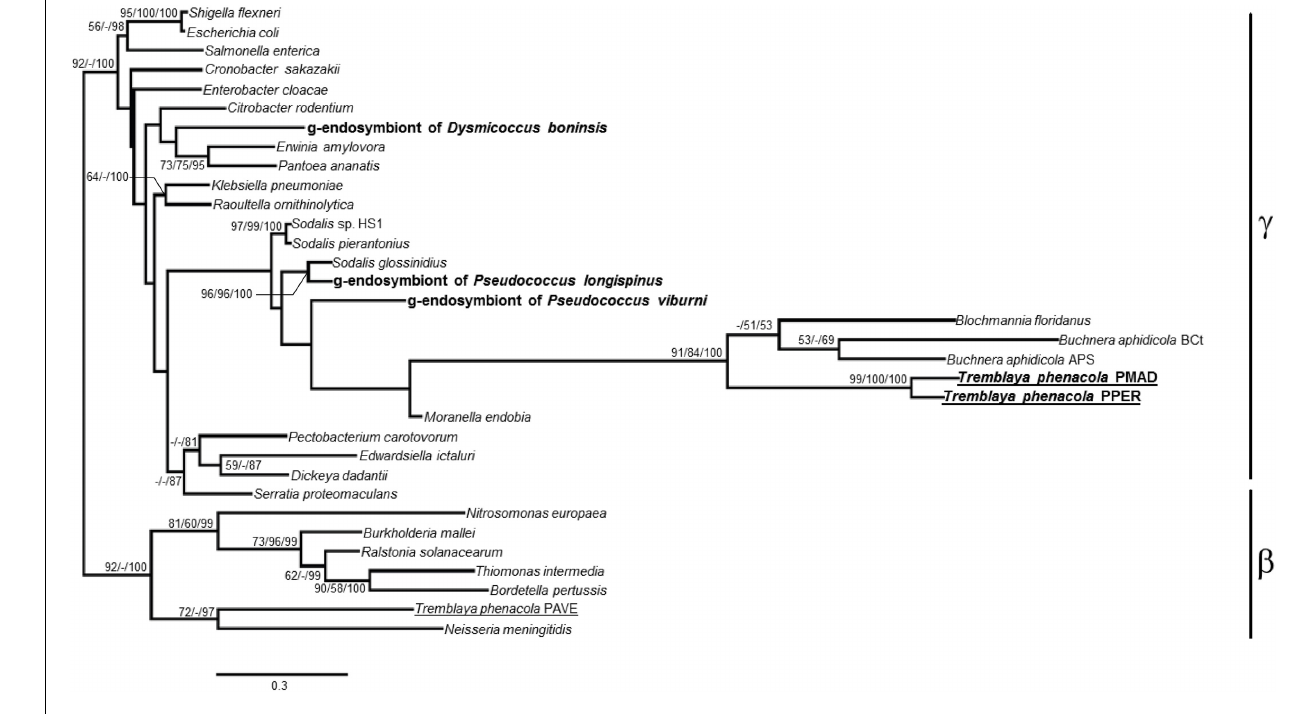
are underlined. Bayesian and MP analysis gave essentially the same results. ML and MP bootstrap values, and Bayesian posterior probabilities over 50% are represented. Scale bar represents substitutions per